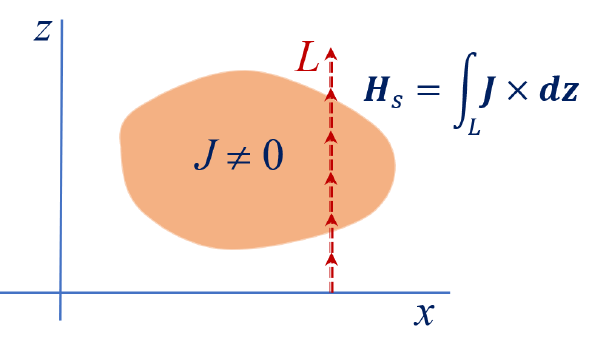
Figure 1. A schematic illustration of the line integral (13) (2D